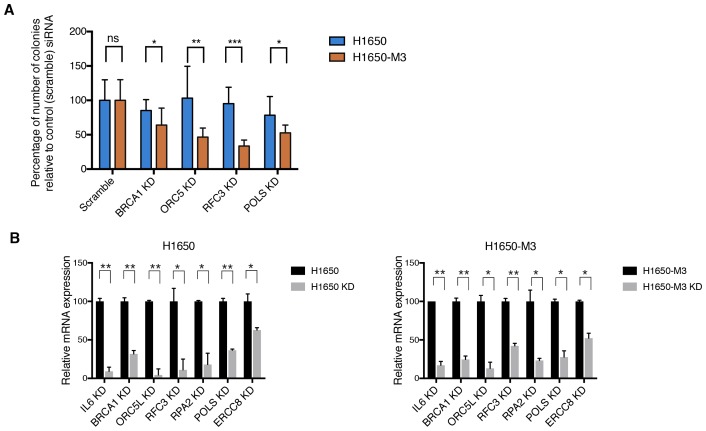
Validation of shRNA screen hits in H1650 and H1650-M3 cells using the clonogenic assay technique.(A) Clonogenic assay performed on H1650 and H1650-M3 to validate siRNA screen hits for BRCA1, ORC5L, RFC3, and POLS. The charts represent the percentage of viable cells 15 days after transfection with the indicated siRNA oligonucleotides compared to that of scramble-siRNA-transfected control cells. Each bar represents mean ± SD of data collected from ten fields from three different six-well plates (n = 30). (B) Knockdown efficiency for clonogenic assay upon transfection with the indicated siRNA oligonucleotides. Samples were collected 3 days post-transfection and analyzed by immunoblot analysis with antibodies against Total caspase 3, alpha-tubulin and Cleaved-caspase 3. Each bar represents mean ± SD of three replicates. p-value *<0.05, **<0.005, ***<0.0005, unpaired t-test. Non-significant differences are shown by the symbol ‘#’ or ‘ns’.